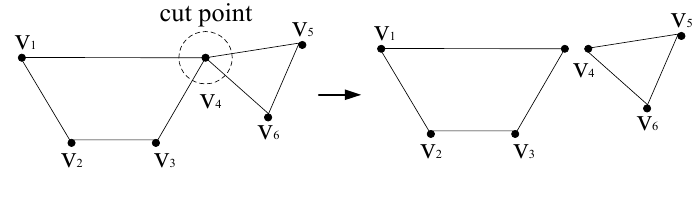
Figure 3. The cut point in a graph.